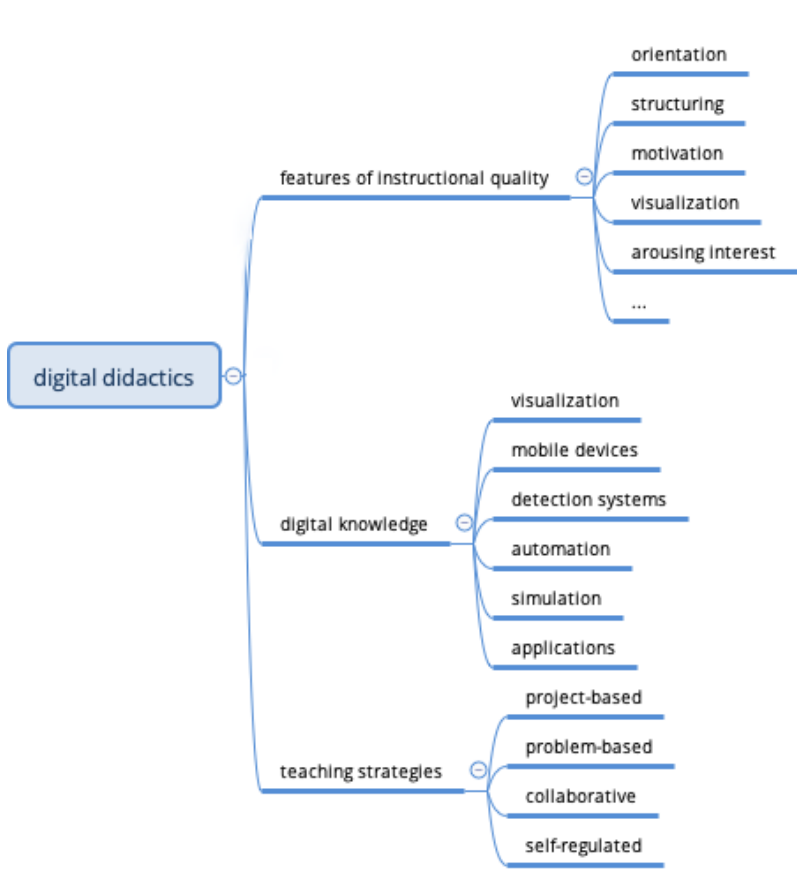
Figure 3. Example of a taxonomy representing digital